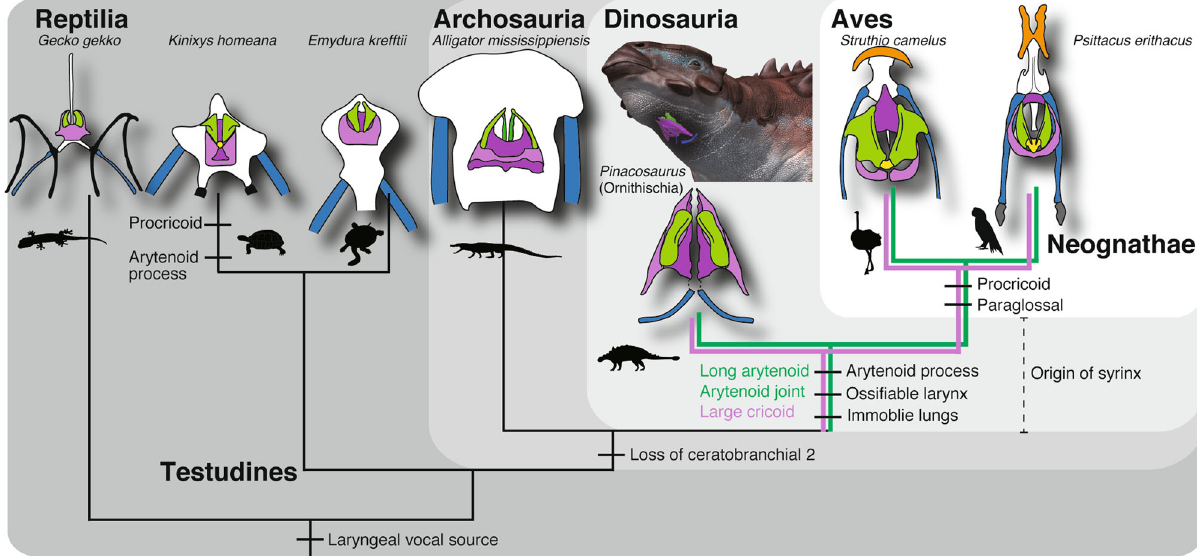
Fig. 4 Evolution of hyolaryngeal apparatus in Archosauria. Ceratobranchial (blue), basihyal (white), paraglossal (orange), cricoid (purple), arytenoid (green), and procricoid (yellow). Colored lines indicate presence of the characters. A phylogenetic relationship of Testudines follows (ref. 43 ). A fl esh-out reconstruction of Pinacosaurus with its hyolaryngeal apparatus (illustration by Tatsuya Shinmura). Silhouettes from Phylopic (http://phylopic.org)